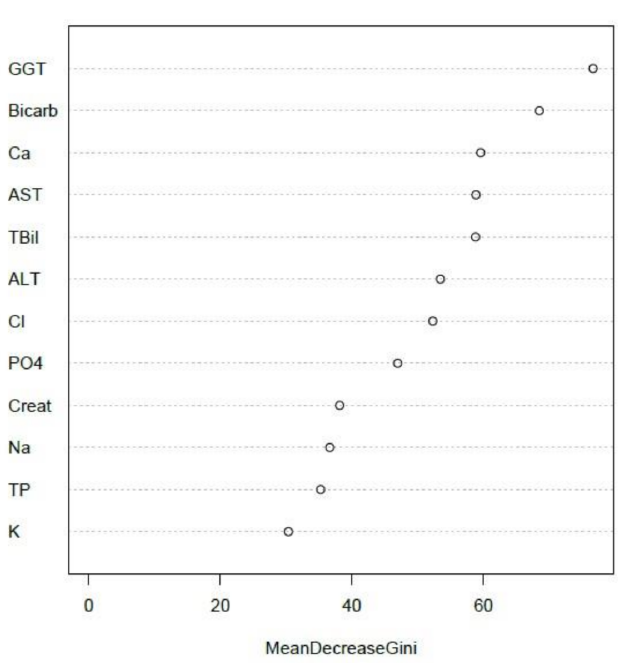
Figure 6. Ranking of EQA markers as calculated by an unsupervised random forest model (no NATA Class response included). The model includes the relative deviation values of all markers assessed over 16 EQA challenge cycles conducted over 4 months (2017) from 39 laboratories ( n =